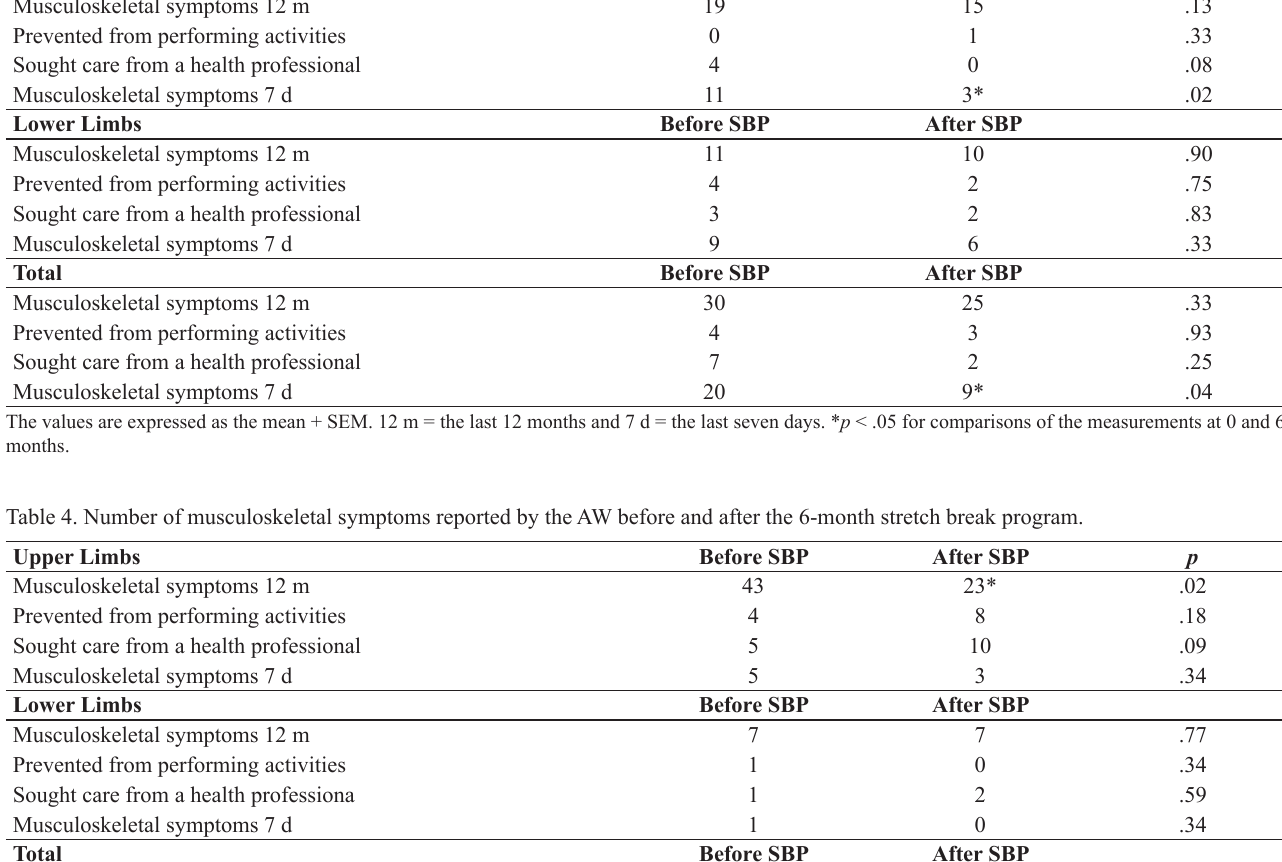
Table 3. Number of musculoskeletal symptoms reported by the SW before and after the 6-month stretch break program. Upper Limbs